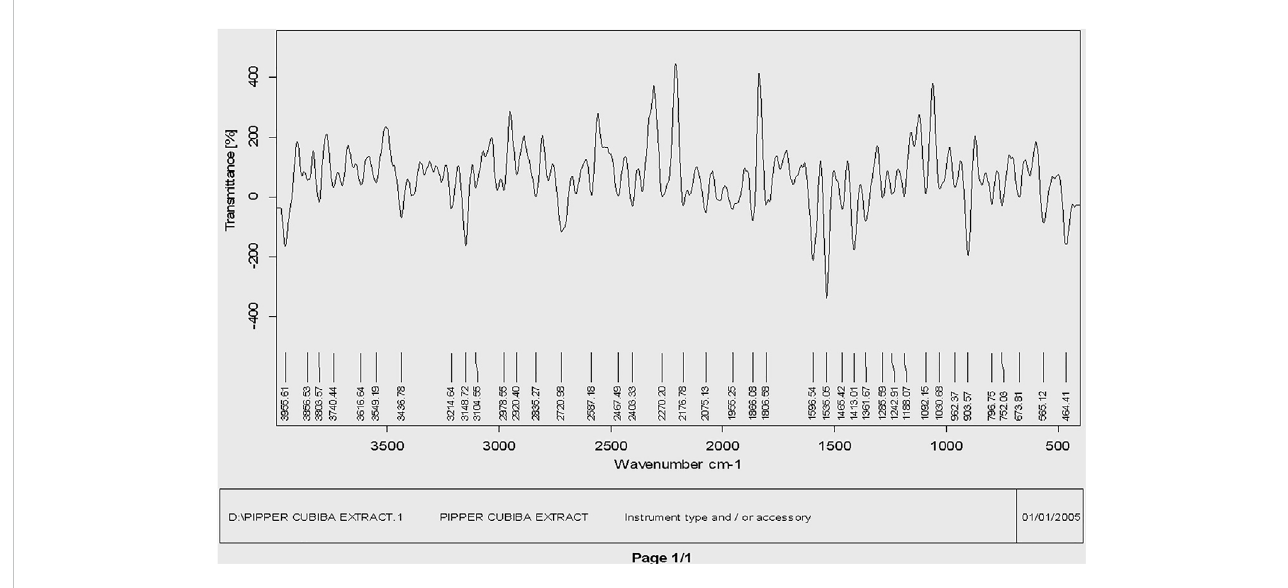
FIGURE 2 FTIR spectra of the Piper cubeba crude extract.